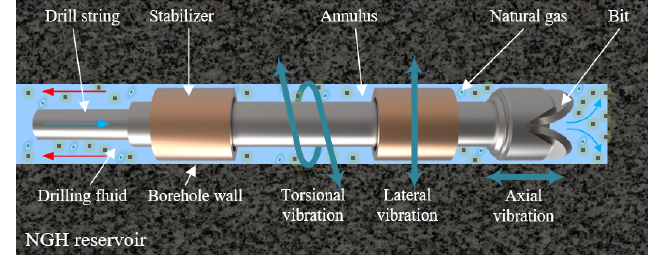
Figure 3. Drilling in the NGH